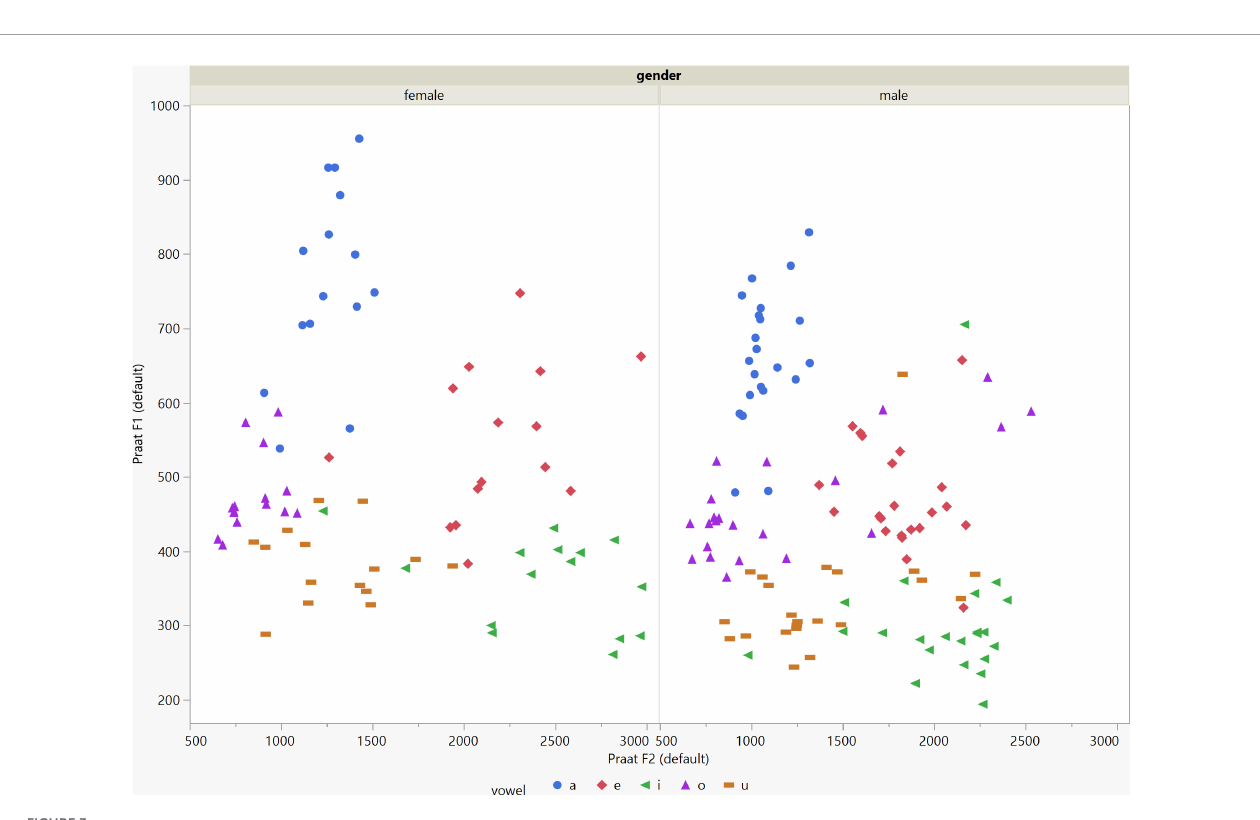
Frontiers in Neuroscience